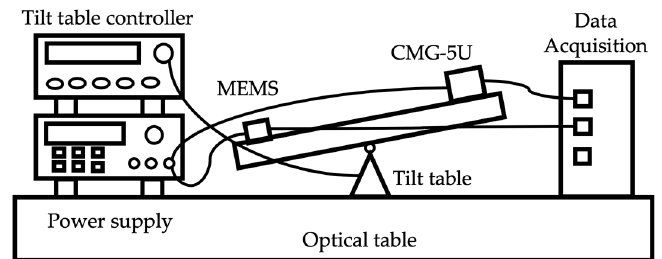
Figure 10. The calibration test diagram of the accelerometer.